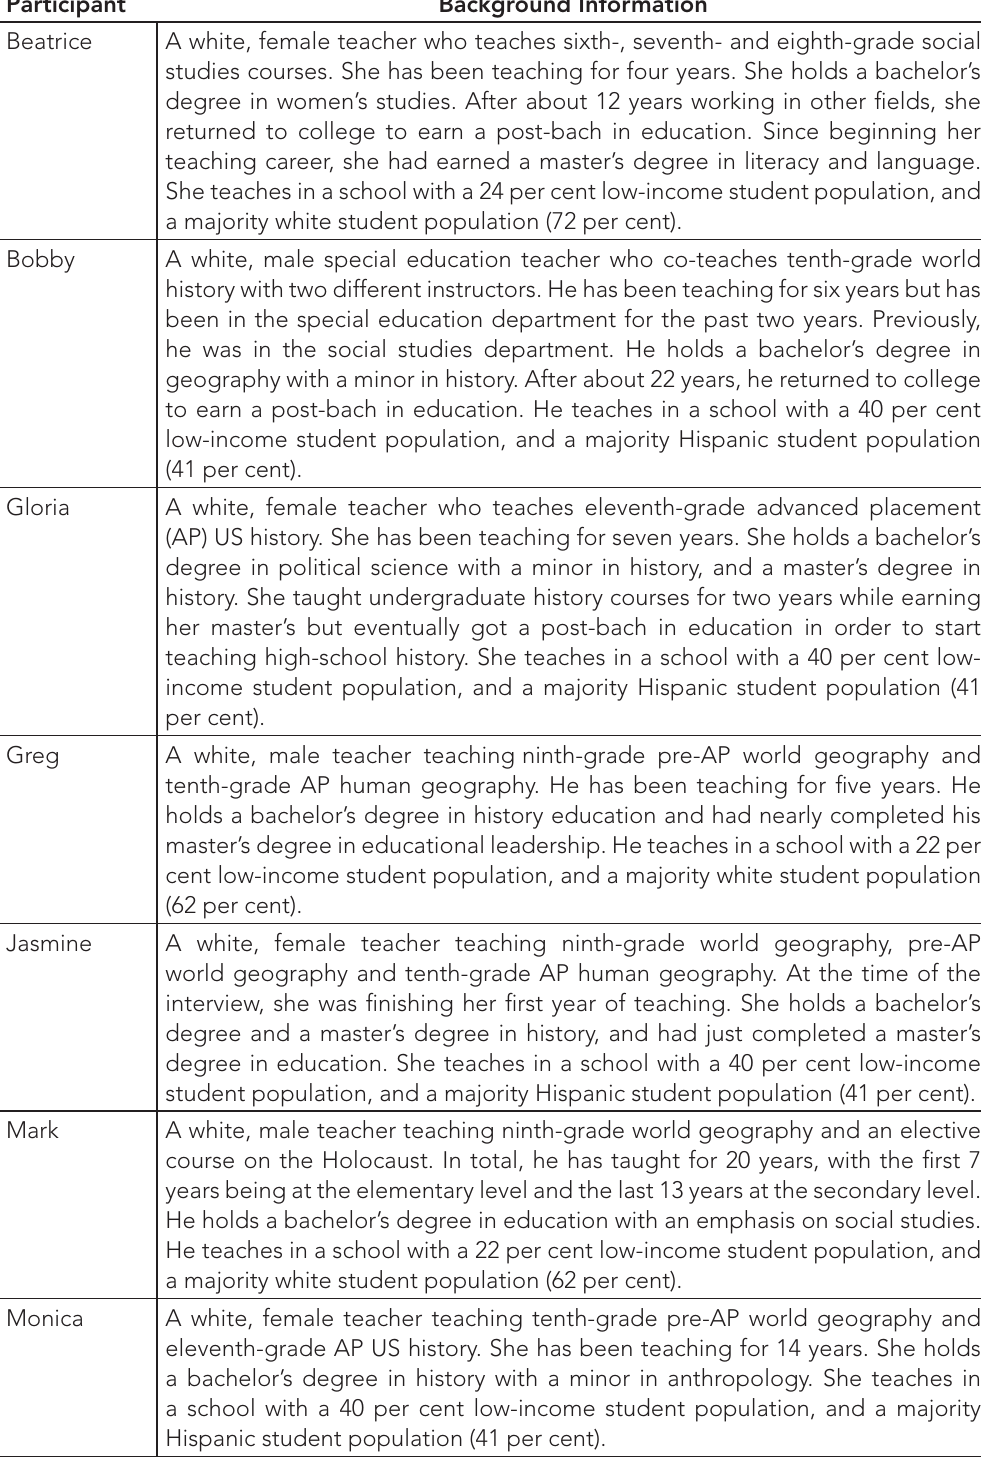
Table 1: Background information on